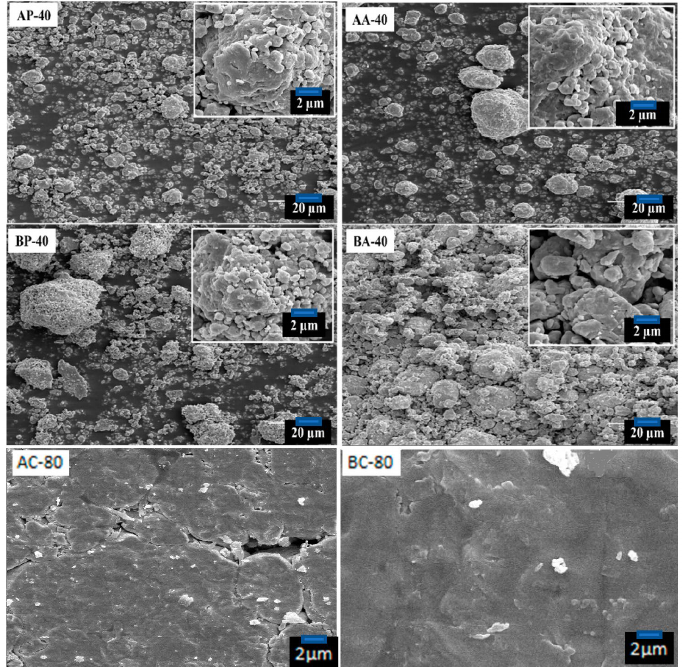
Figure 1. SEM images corresponding to samples AP-40, AA-40, BP-40, BA-40, AC-80, and BC-80.